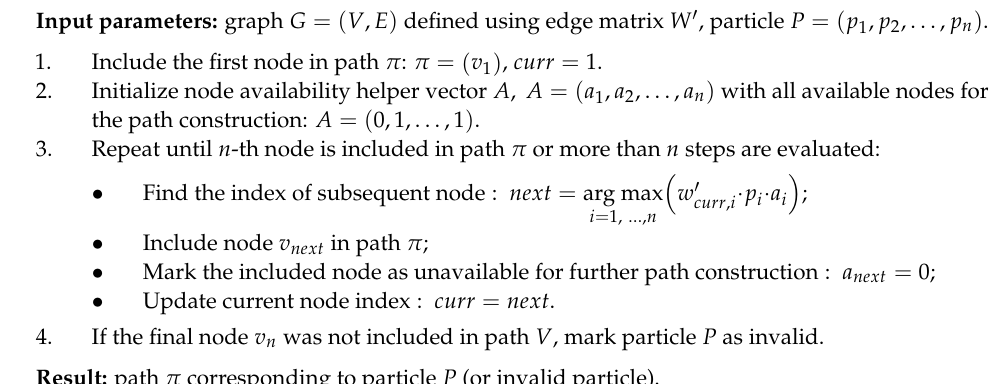
Algorithm 1: Path construction